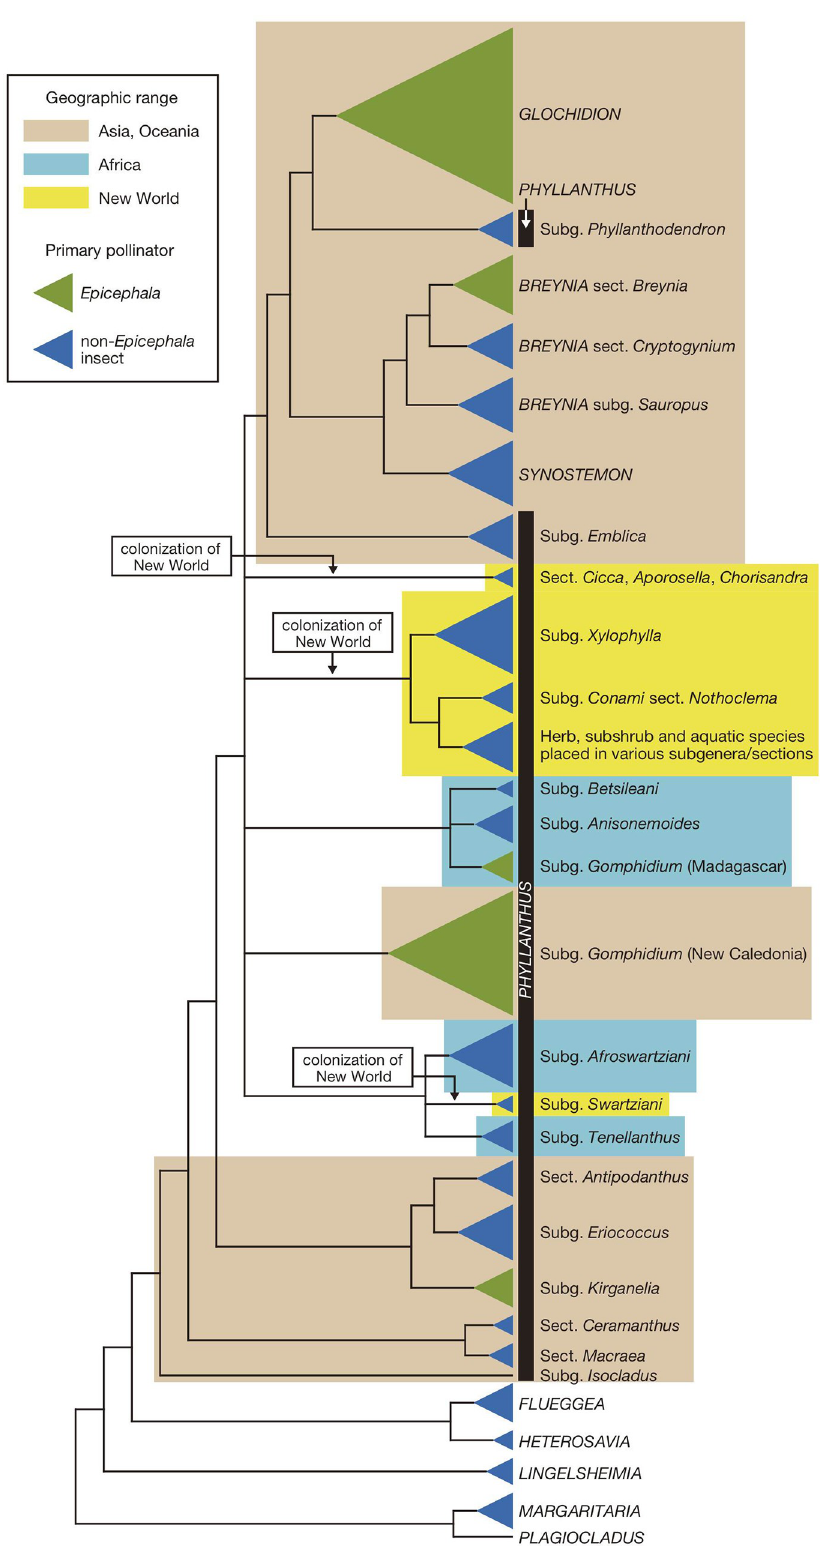
Fig 1. Phylogeny of the tribe Phyllantheae. The tree is based on the most recent molecular phylogenetic analyses of the tribe [12,14].Species richness of each terminal clade is provided as the area of the clade triangle. The five clades